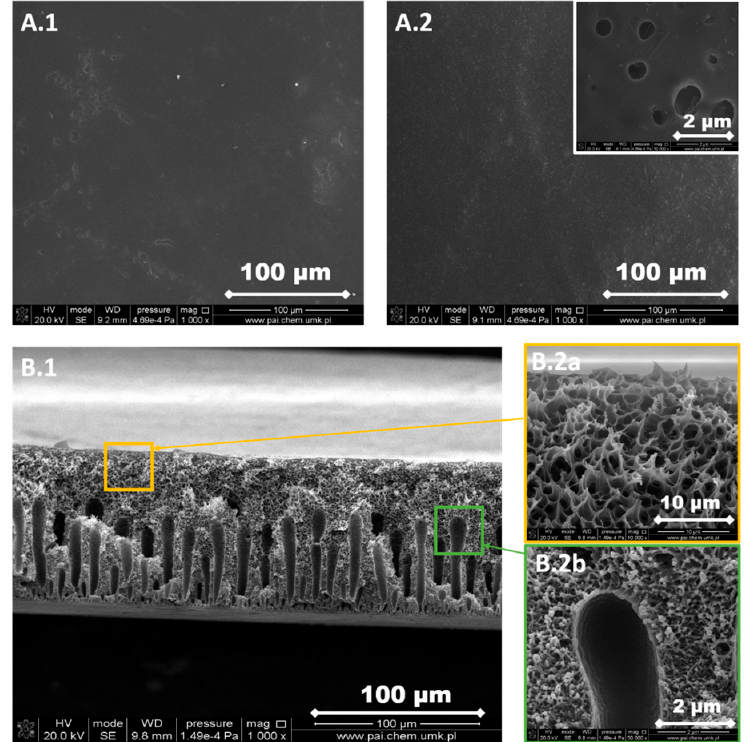
Figure 7. SEM images of M5 membrane. ( A.1 ) Selective layer, ( A.2 ) support layer, ( B.1 ) a cross-section of the membrane, and ( B.2a,b ) a cross-section of the membrane at higher magnification.